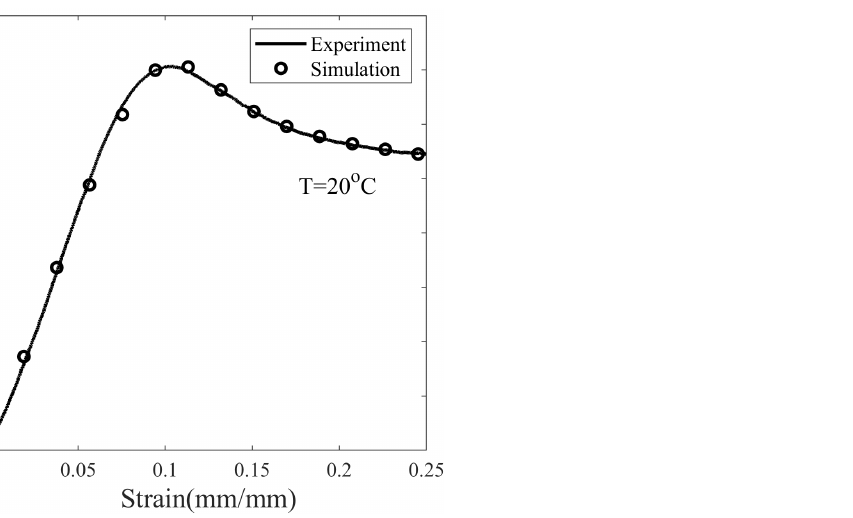
Figure 5. The stress–strain response of SMP deformed with a strain rate of 0.0013 s − 1 at T = 20 °C in the glassy state.